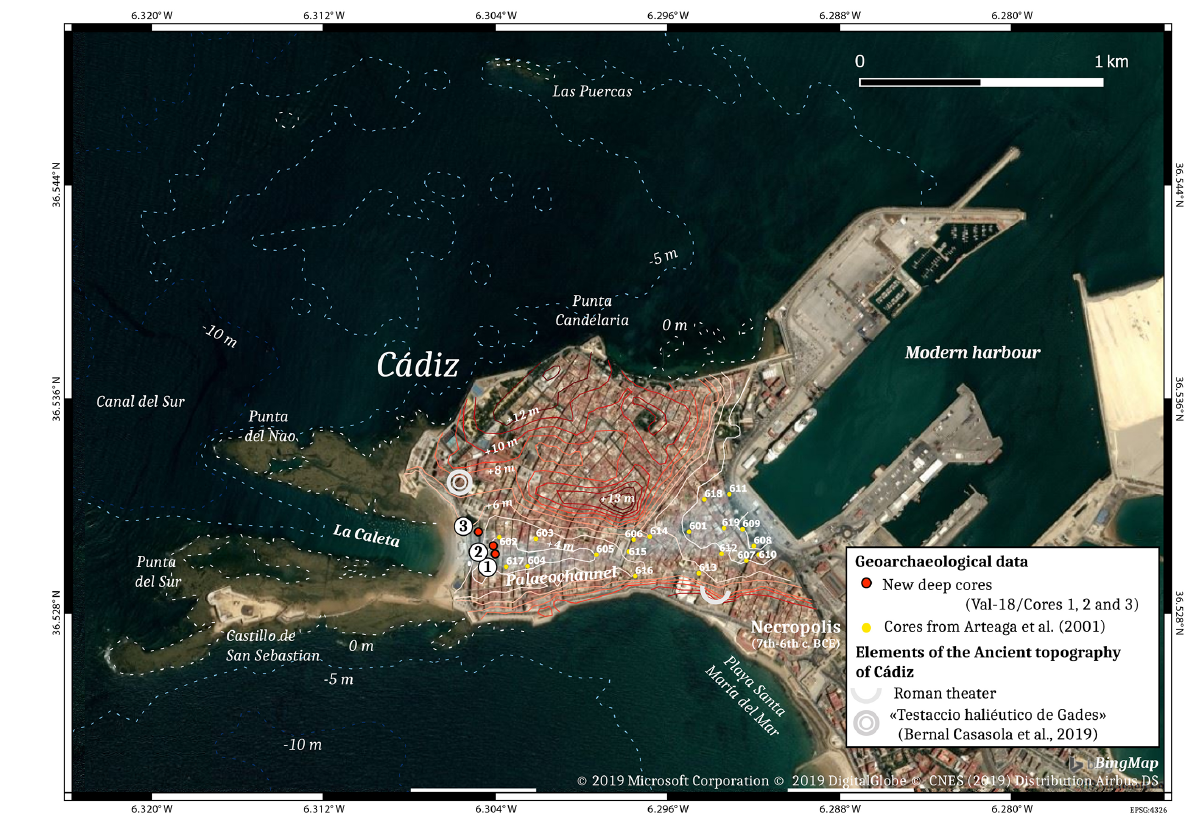
Figure 3. Locations of the three new deep cores in the context of the studied area. Bathymetric data (http://www.gpsnauticalcharts.com, last access: 11 February 2020), topographical data (collected in 1911; Ramírez Delgado, 1982), and previous cores (Arteaga et al., 2001) are reported in this